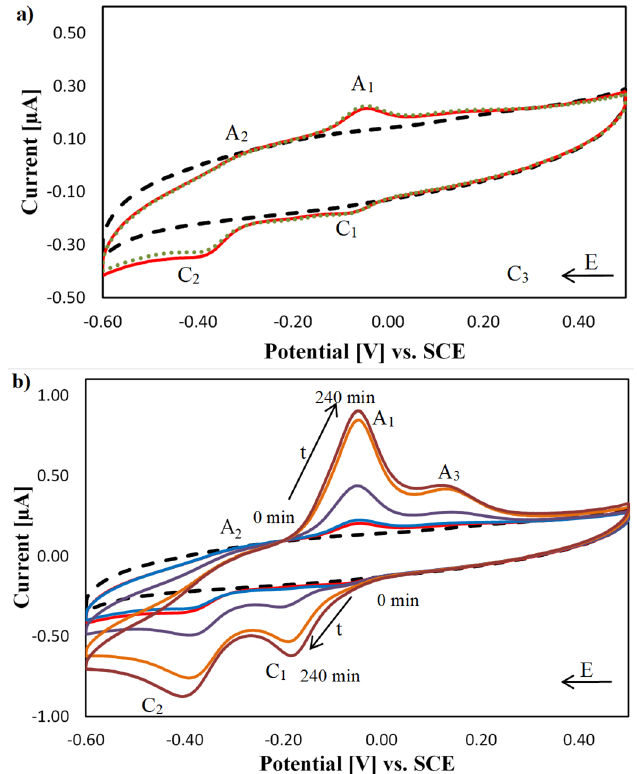
Figure 5. Typical cyclic voltammograms, obtained at 100 mV s − 1 scan rates, registered at the DNA biosensors in 0.1 M PB, pH 7.0 (black dashed trace), and in 20 μ M of [Cu(TPMA)(PD)] 2+ ( a ) just after addition (red solid trace) and after 60 min (green dotted trace); ( b ) over time using a single DNA sensor: 0 min (red trace); 60 min (blue trace); 120 min (violet trace); 180 min (orange trace); and 240 min (brown trace).